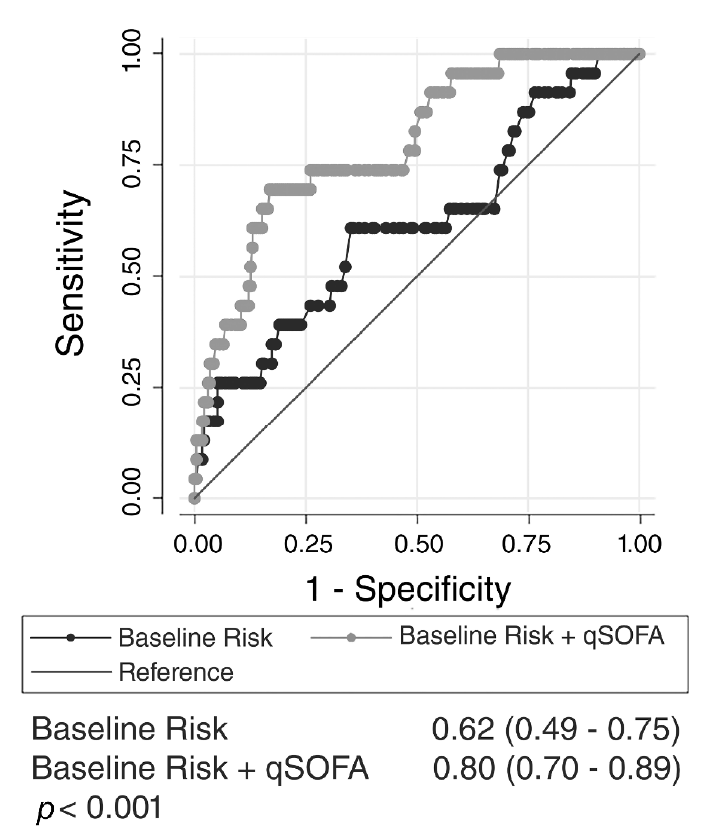
Figure 4. Receiver operating characteristic curves for baseline risk compared to baseline risk added to quick sequential organ failure assessment (qSOFA) score for all patients with documented staphylococcal infection. Baseline risk model includes age, sex, and co-morbidities associated with the outcome.